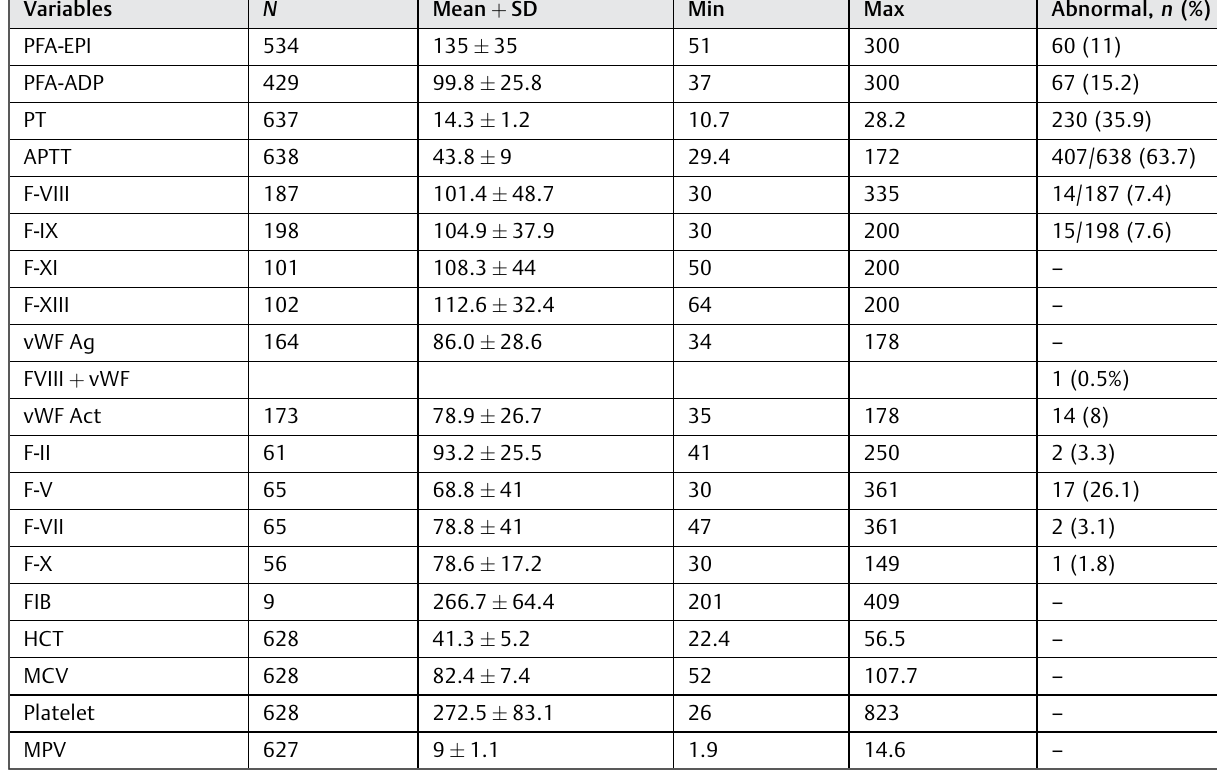
Table 1 Basic descriptive analysis for laboratory results